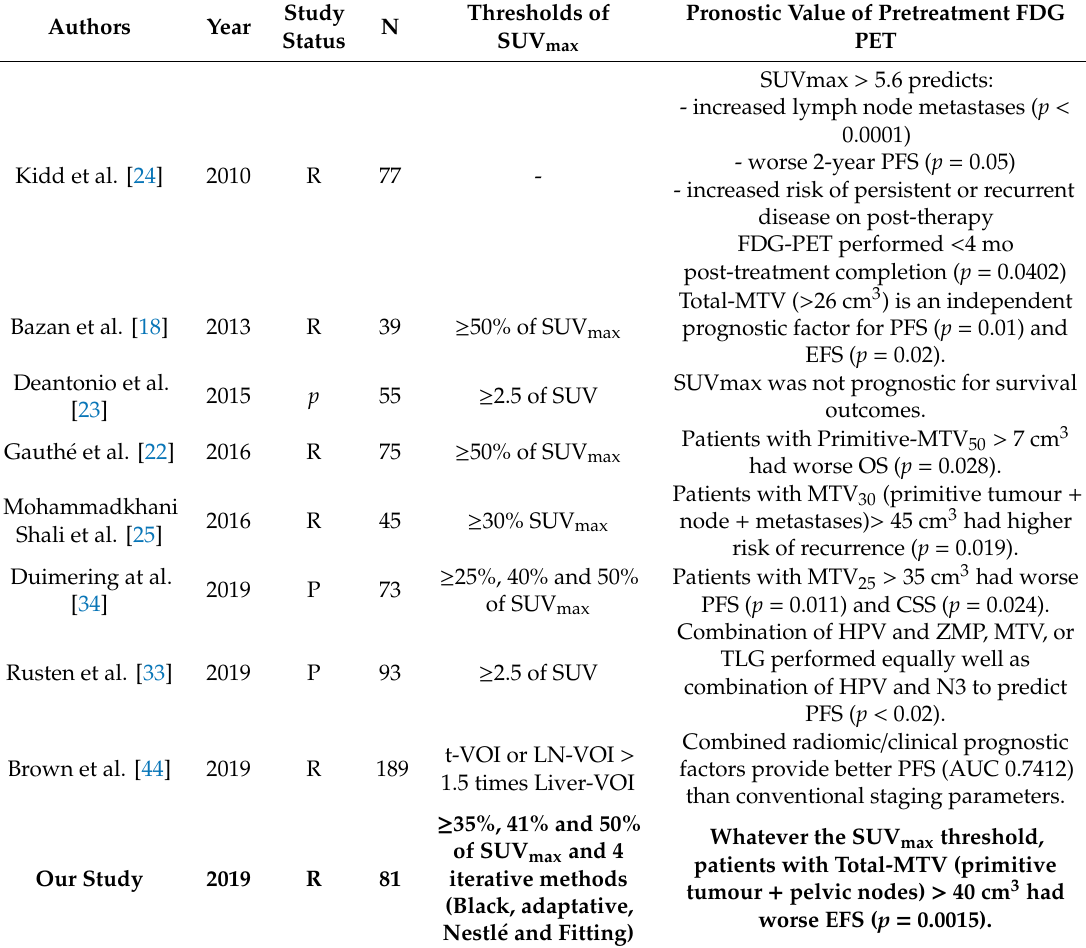
Table 4. Literature review. Prognostic performances of pretherapeutic FDG-PET in patients with anal SCC